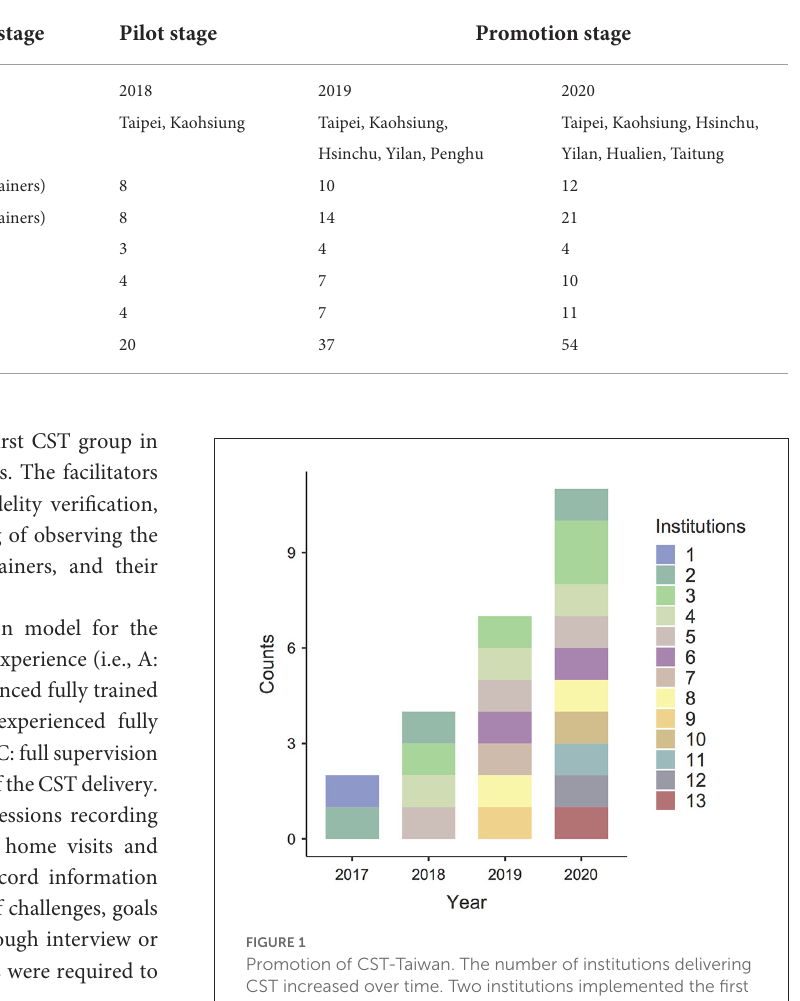
TABLE 2 Promotion summary of CST-Taiwan.